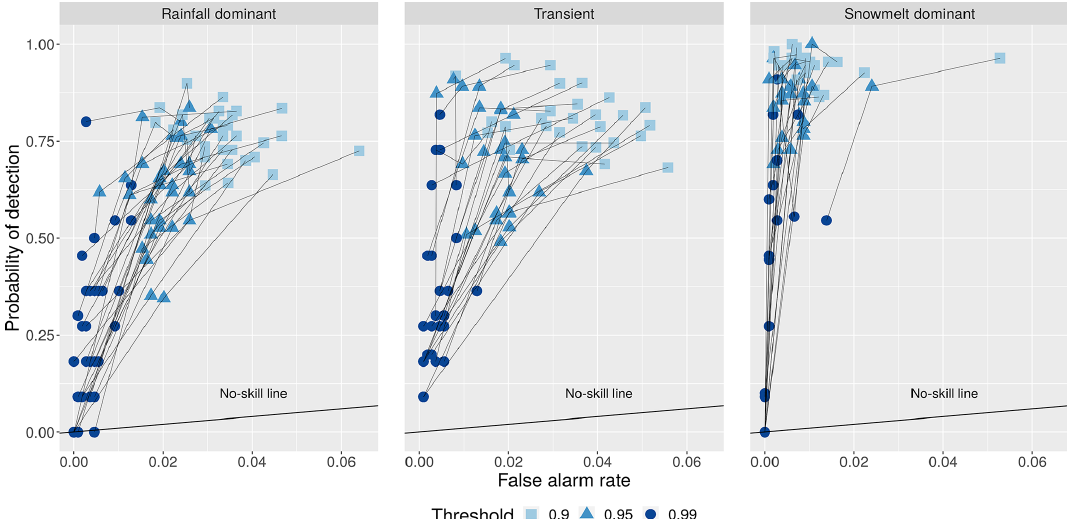
Figure 9. The probability of detection (POD) plotted against the false alarm rate (FAR) for three extreme thresholds: 90th, 95th, and 99th percentiles. The thin black line connects values from the same watershed. The vertical axis indicates the number of times RF correctly forecasted events that exceeded the threshold divided by the total number of exceedance. The horizontal axis indicates the number of times RF incorrectly forecasted events that exceeded the threshold divided by the total number of non-exceedance. It is noted that the scales of the horizontal and vertical axes are not 1-to-1 in the plotted partial receiver operating characteristic (ROC)